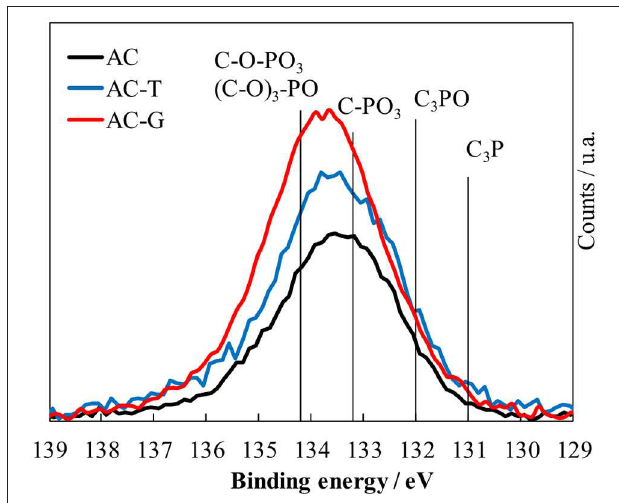
FIGURE 3 | XPS P2p photoemission region of the activated